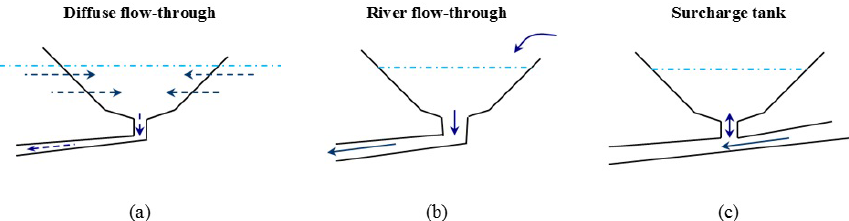
Figure 2. Conceptualisation of diffuse flow-through, river flow-through and surcharge tank turlough systems (modified from Gill et al.,